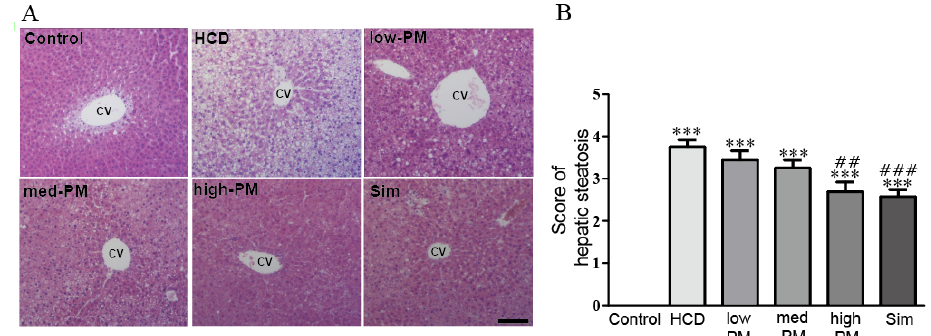
Figure 3. Effects of PM on hepatic steatosis in hypercholesterolemic rat. ( A ) Histological analysis of liver tissue in hypercholesterolemic rats. Liver sections were stained with hematoxylin and eosin (H & E) and examined under a light microscope ( n = 8 per group); ( B ) Scores of hepatic steatosis of hypercholesterolemic rat livers. Scores were determined according to hepatocytes containing lipid droplets ( n = 8 per group). Data are expressed as mean ± SEM. Significance was measured by performing a one ‐ way ANOVA followed by Bonferroni’s post ‐ hoc test. *** p < 0.005 vs. control. ## p < 0.01, ### p < 0.005 vs. HCD ‐ fed group. HCD, high cholesterol diet ‐ fed group; low ‐ , med ‐ , and high ‐ PM: low (1.65 × 10 9 cfu/kg/day), medium (5.5 × 10 9 cfu/kg/day), and high doses (1.65 × 10 10